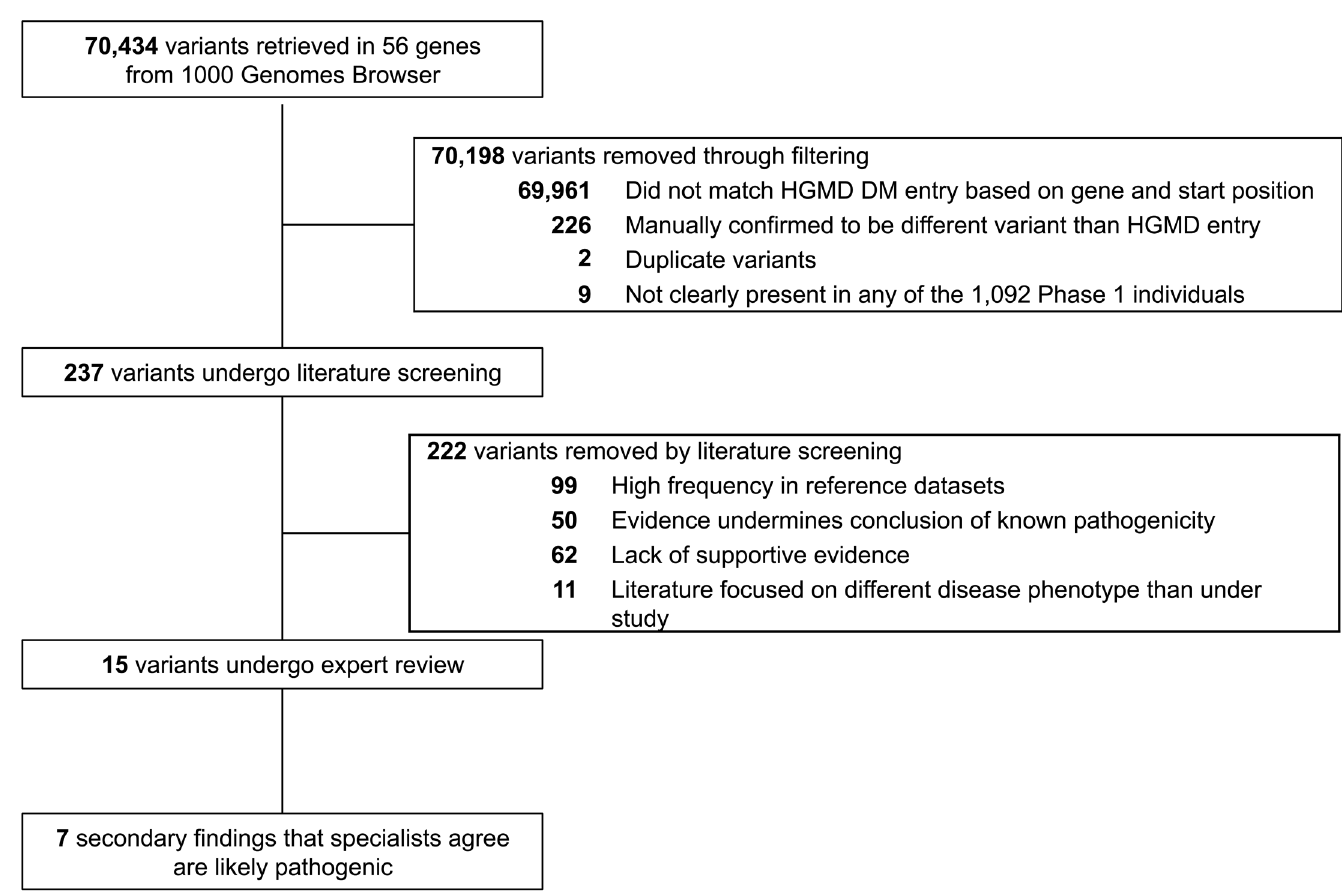
Fig 1. Flow of candidate variants through informatics filtering, literature review, and expert evaluation. Candidate variants in 56 genes associated with 24 actionable conditions from the 1000 Genomes dataset were narrowed down to identify 7 secondary findings that specialists agree are pathogenic or likely